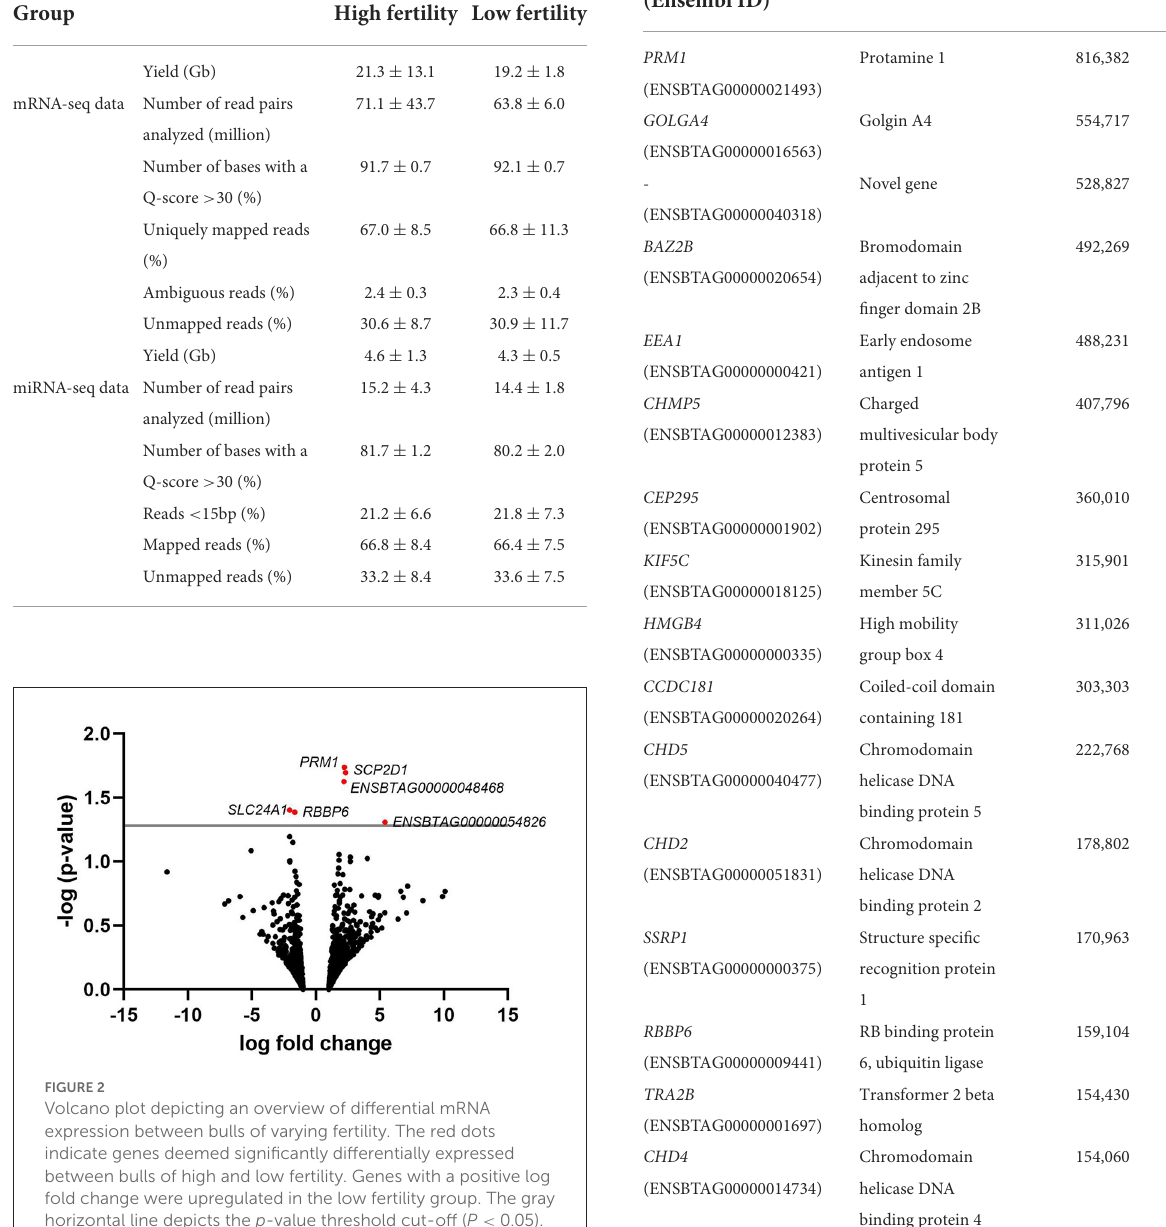
TABLE 1 Library characterization and mapping efficiency on the bovine genome (ARS-UCD1.2) of in mRNA-seq and miRNA-seq libraries.